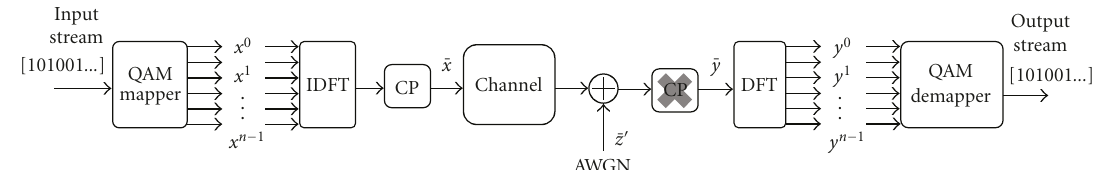
Figure 3: DMT transmission over a twisted-pair channel with additive white Gaussian noise (AWGN). The figure shows the basic transmitter and receiver blocks of the modem-pair.